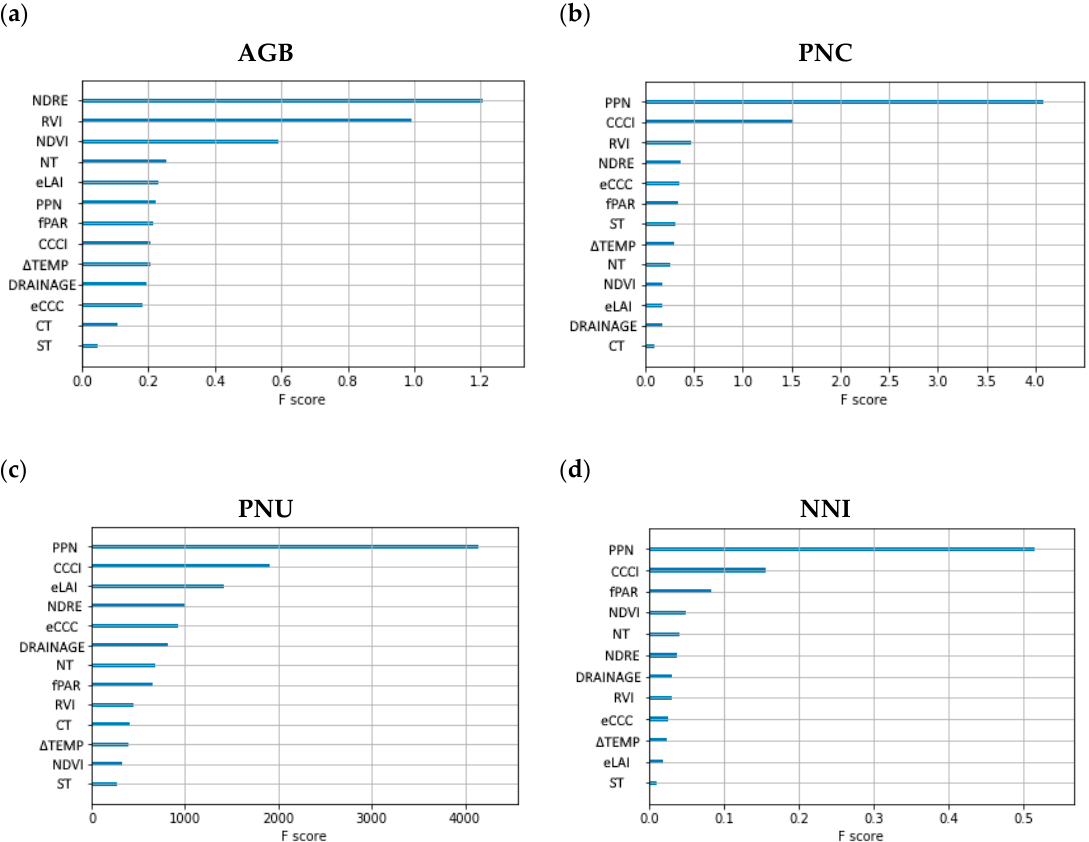
Figure 7. Relative importance of sensor metrics and management variables for predicting ( a ) AGB, ( b ) PNC, ( c ) PNU, and ( d ) NNI as represented by the F score values from XGB regression .